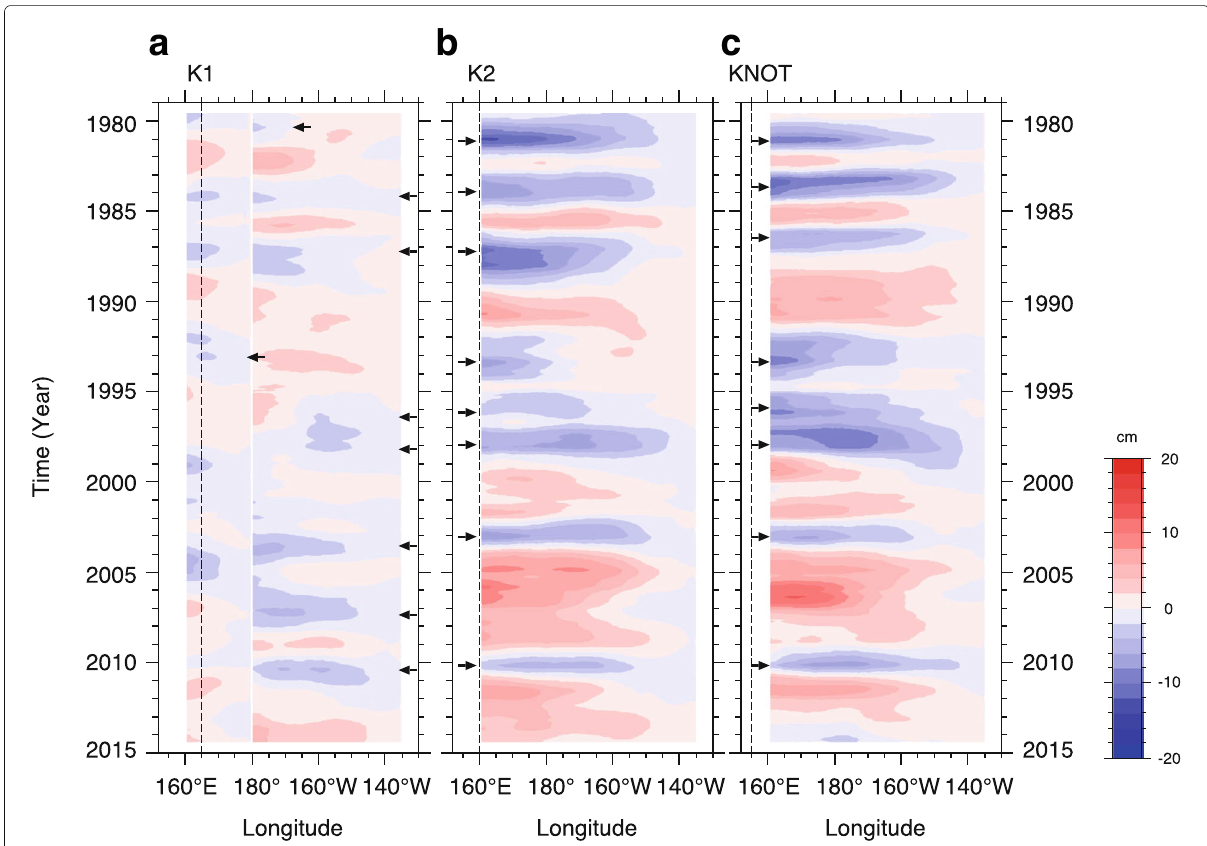
Fig. 12 a – c Same as Fig. 9 but for the SSH variations due to the barotropic Rossby wave mode ( n = 0) forced by the wind stress. In panel a , the wind stress data in the region east of 180° were not used for the calculation of the SSH anomaly in the western region. Arrows show El Niño-related SSH depressions